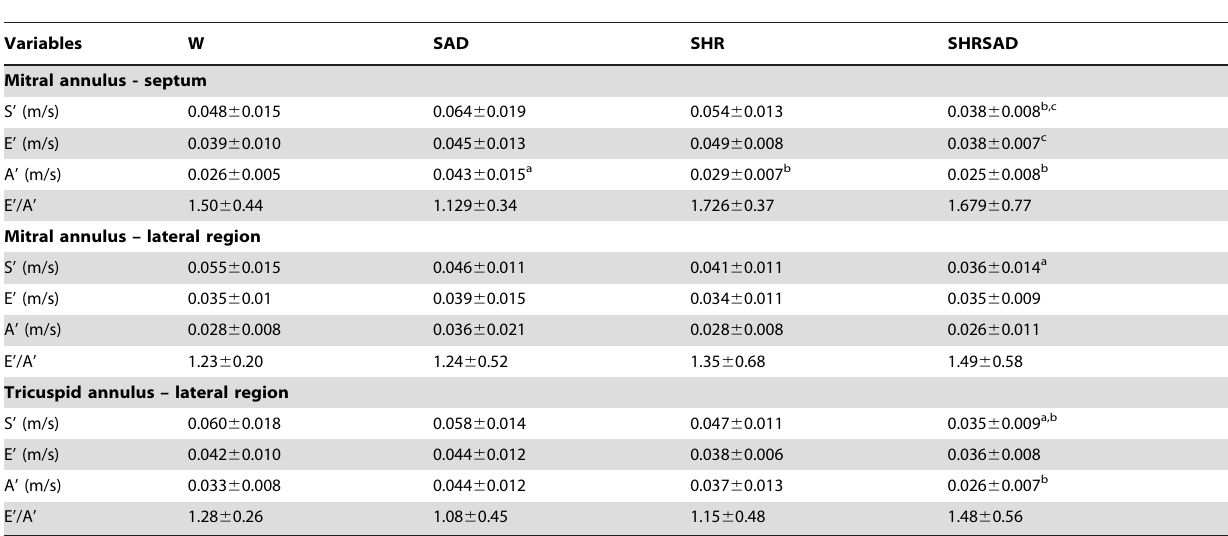
Table 3. Tissue Doppler imaging data of mitral and tricuspid annulus data obtained by transesophageal echocardiography.